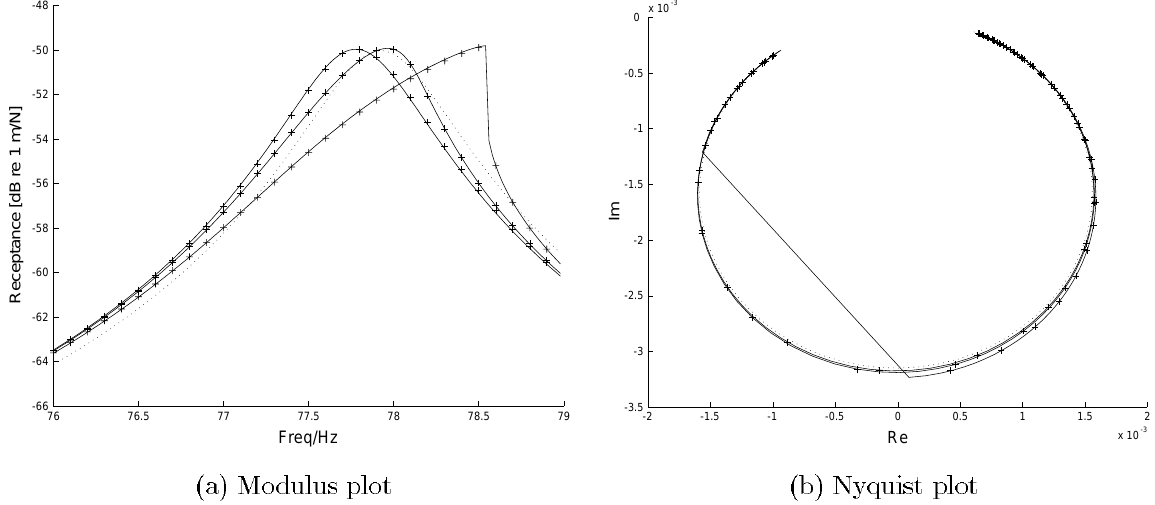
Fig. 7. Response predictions with an approximate underlying linear model: ... Regeneration with linear modal parameters only, HBM simulations, ++ Regeneration with non-linear